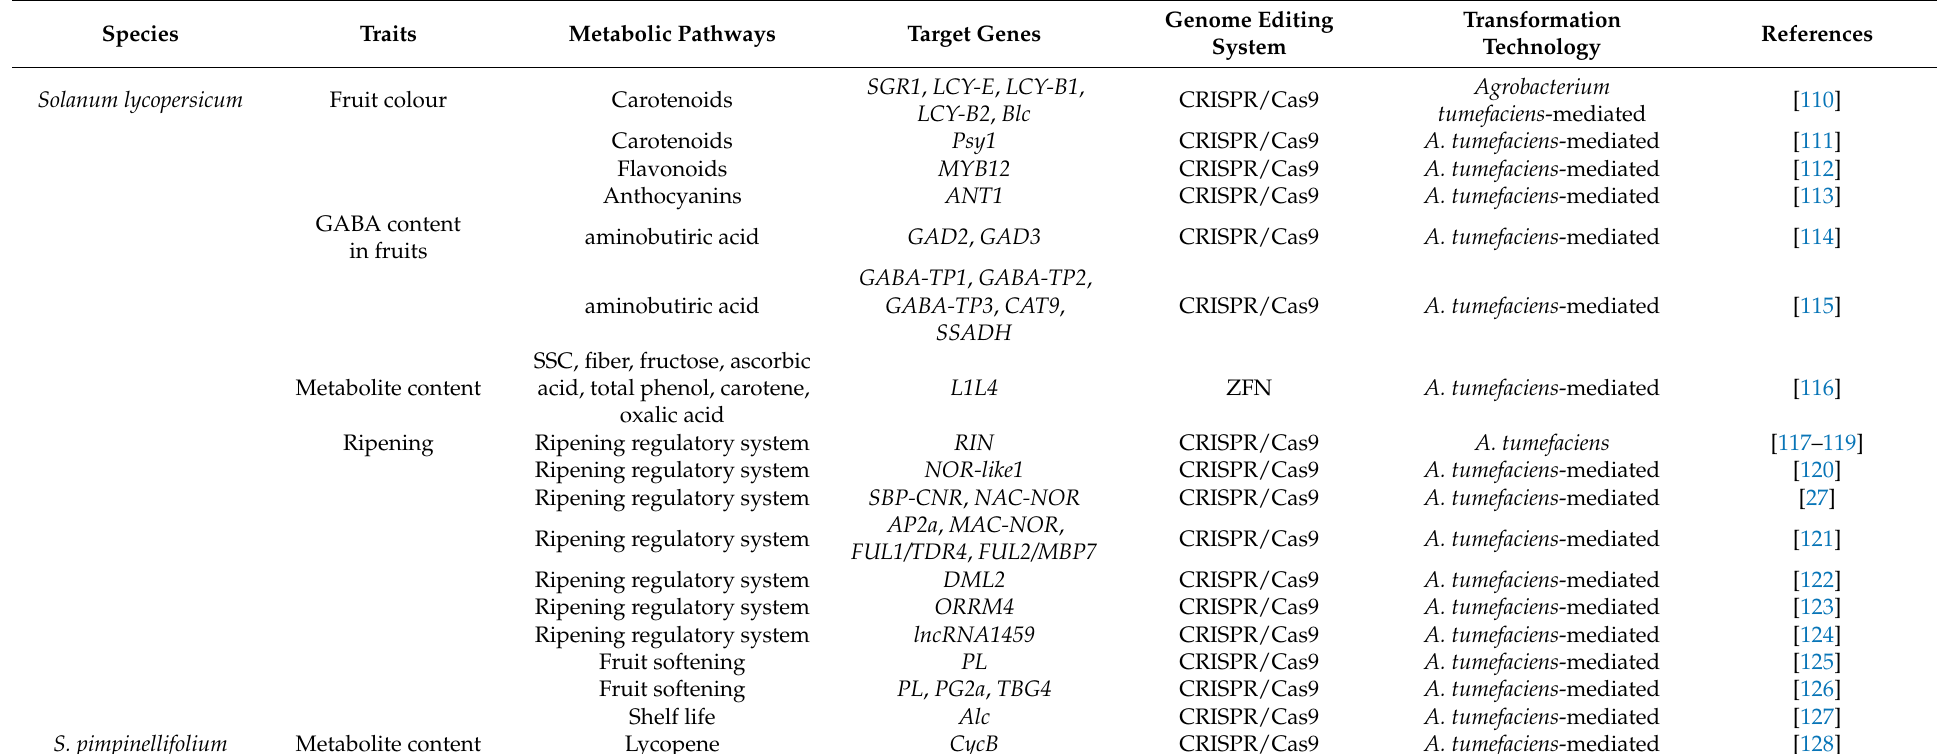
Table 2. Examples of organoleptic and nutritional quality traits modified by genome editing in